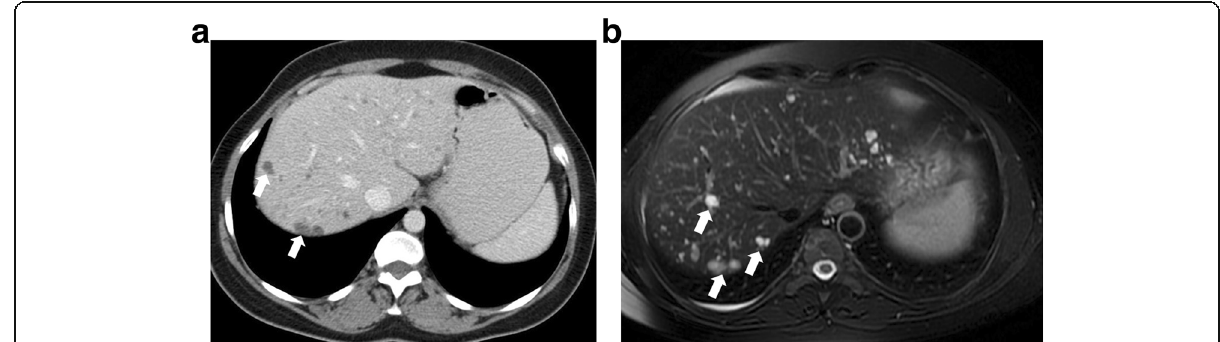
Fig. 11 A 48-year-old female patient with known breast cancer underwent abdominal CT scanning for distant metastasis evaluation. a Axial plane post-contrast CT image shows multiple hypodense lesions (arrows) in both liver lobes. b Axial plane fat-saturated T2W MR image shows multiple cystic lesions (arrows) consistent with biliary hamartomas